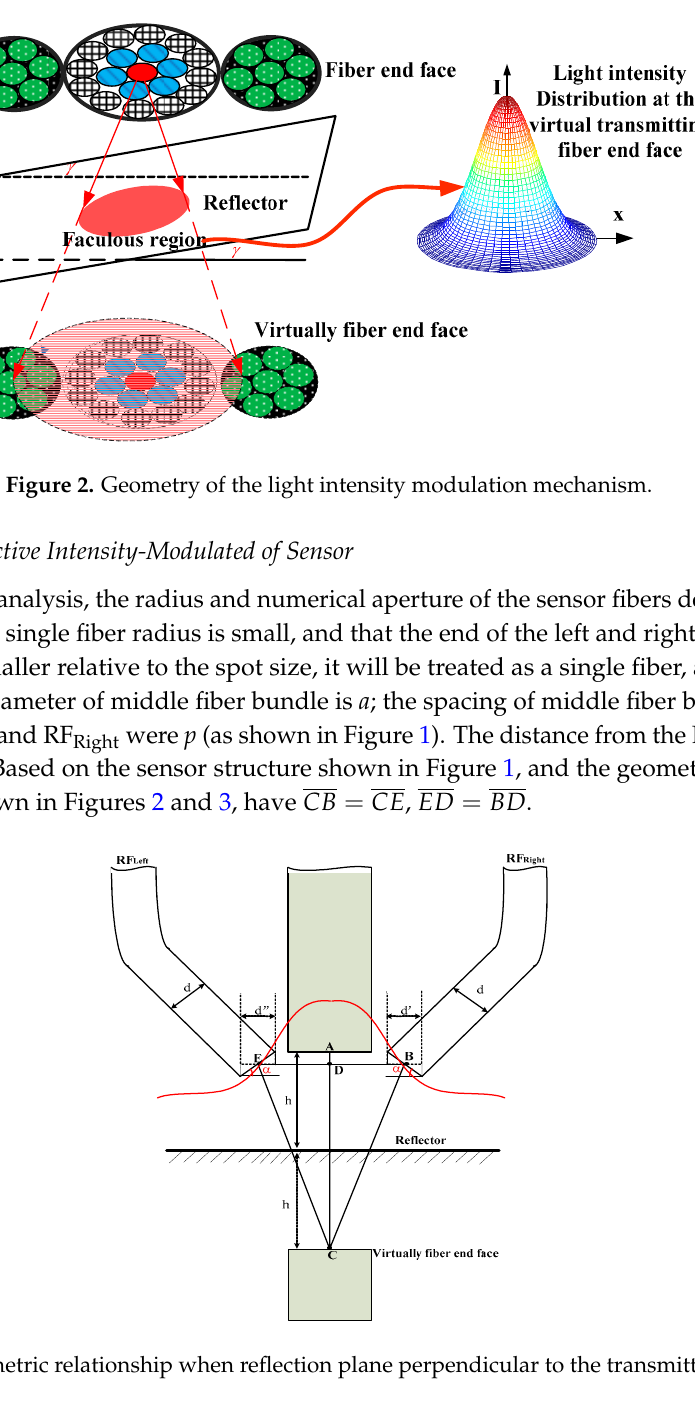
Figure 3. Geometric relationship when reflection plane perpendicular to the transmitting optical.